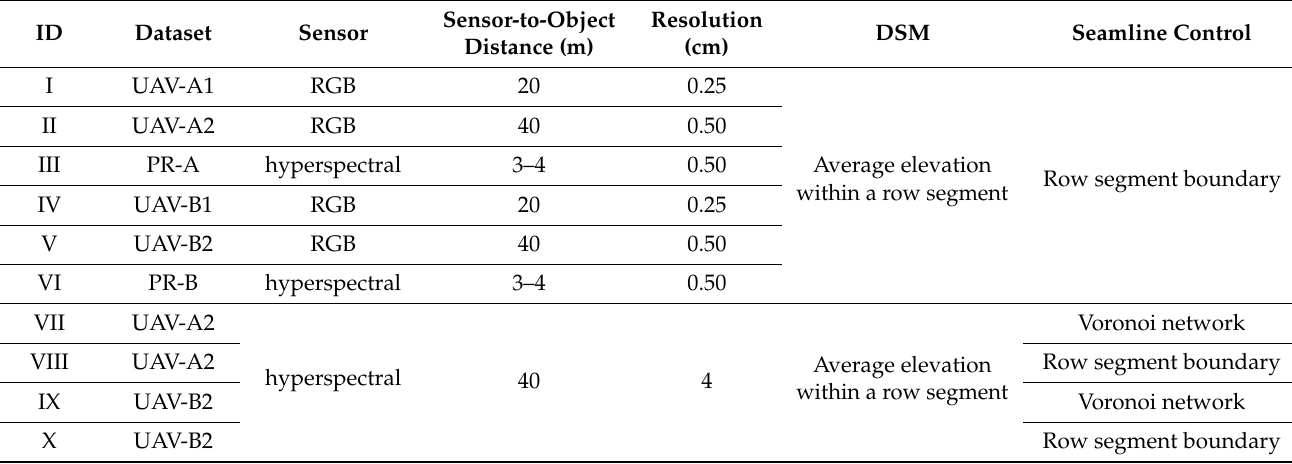
Table 4. Experimental setup of the system, sensor, sensor-to-object distance, resolution, DSM, and seamline control strategy for orthophoto I to X